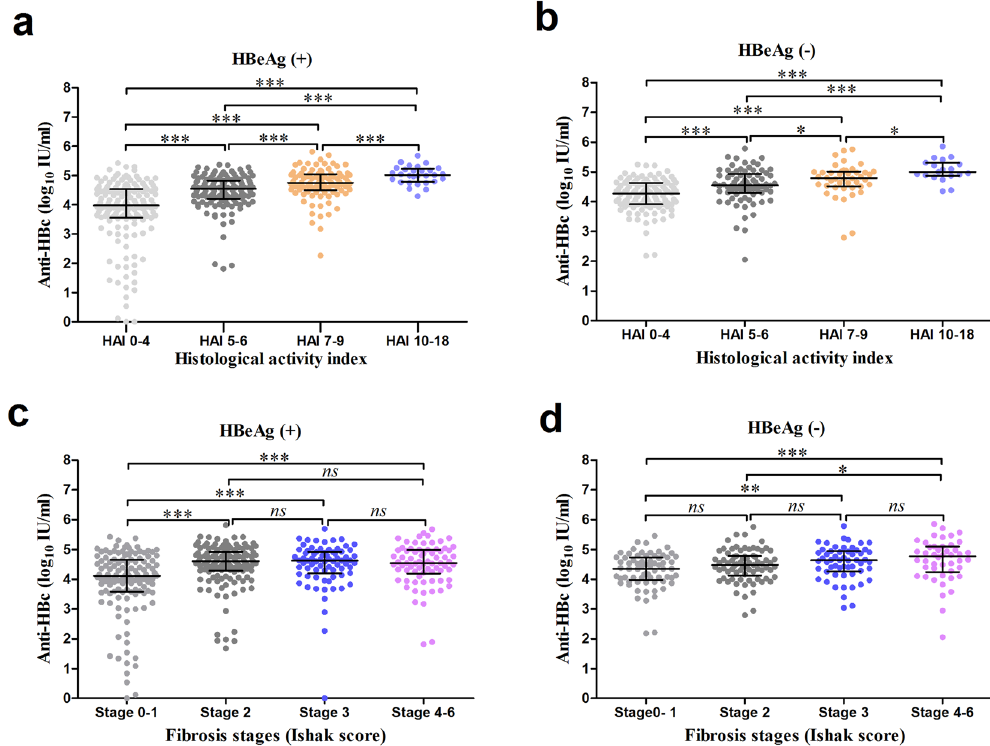
Figure 1. Serum anti-HBc level increased significantly along with increasing histology activity index score. Serum anti-HBc level in different stages of histology activity index score in total HBeAg ( + ) ( a ) and HBeAg ( − ) ( b ) CHB patients. Serum anti-HBc collected from patients with different stages of CHB-related liver inflammation was quantified for the levels of anti-HBc using ELISA. Graph showing correlation between serum anti-HBc level and stages of liver fibrosis HBeAg ( + ) ( c ) and HBeAg ( − ) ( d ) CHB patients. Interquartile ranges with medians presented. *** P < 0.001, ** P < 0.01, * P < 0.05 and ns , no